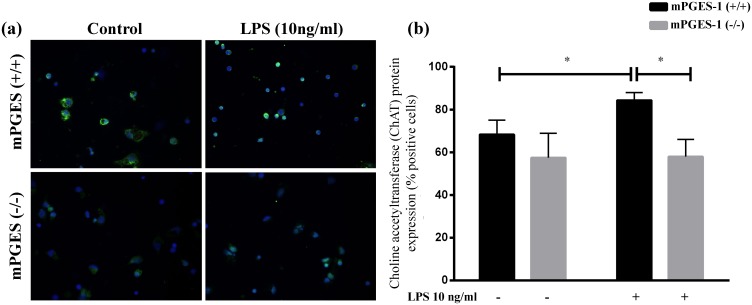
LPS fails to increase choline acetyltransferase (ChAT) expression in the absence of mPGES-1 expression.Primary splenocyte cultures from mPGES-1(+/+) and (-/-) mice were grown on chamber slides and treated with the endotoxin, LPS (10ng/ml). Following 20 hour treatment, cells were paraformaldehyde fixed and stained for ChAT protein expression. (a) Representative microscope images showing ChAT staining (green) and nuclear staining with DAPI (blue). (b) Microscopic analysis of unstimulated and LPS treated mPGES-1(+/+) and (-/-) splenocytes. (* p<0.05; LPS versus control within mPGES-1(+/+); Mann-Whitney Test). (*p<0.05; mPGES-1(+/+) versus (-/-) within the LPS treatment group; Mann-Whitney Test). Each treatment condition was performed in duplicates on the chamber slides and values are represented as mean ±SEM. Quantitative analysis for ChAT positive cells includes measurement of 7 different fields obtained from two independent experiments.